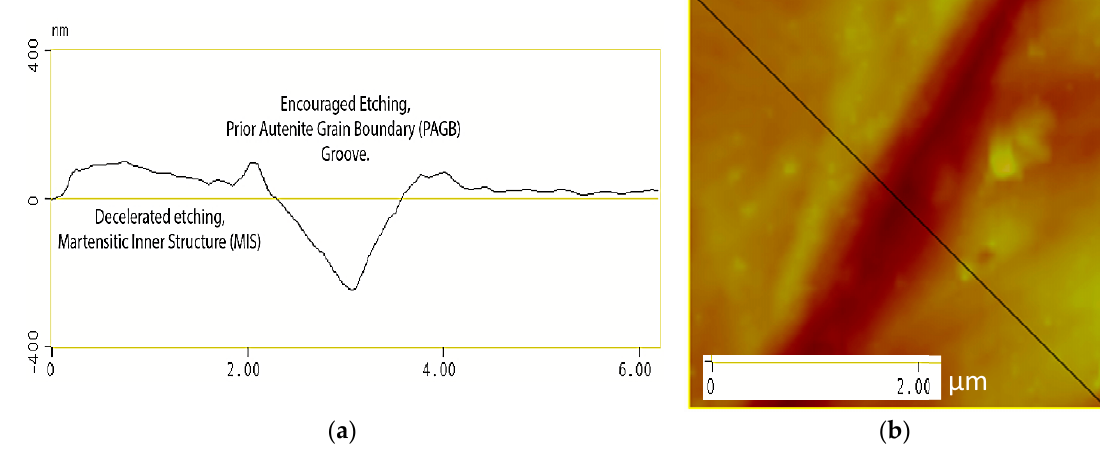
Figure 10. Surface analysis of the prior austenite grain boundary shown in ( a ) and the two-dimensional image shown in ( b ).